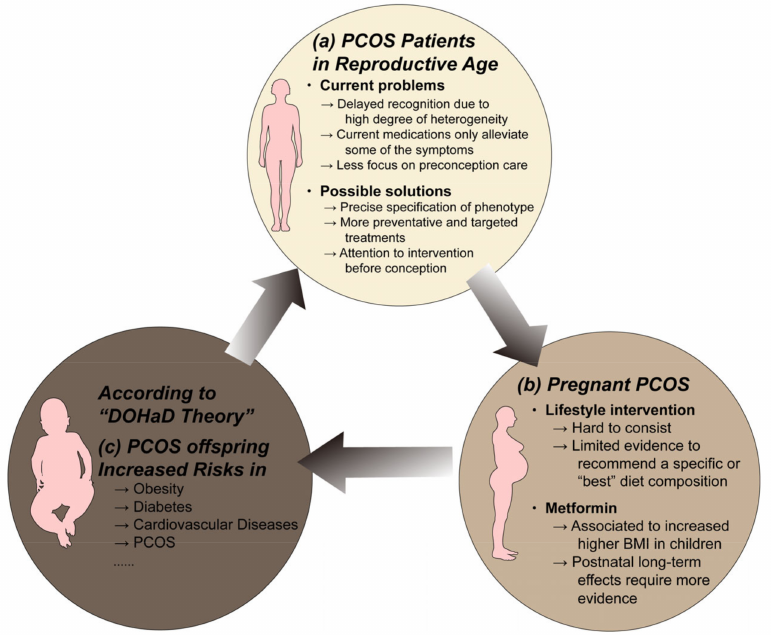
Figure 2. The vicious circle of intergenerational transmission of PCOS. (a) Many challenges remain in the diagnosis and treatment of PCOS in reproductive age. The concurrent metabolic disturbances in PCOS will bring risks to both mother's and offspring's health. (b) Lifestyle intervention and metformin are the first-line treatment for PCOS and they are safe for use during conception. However, their efficiency in benefiting PCOS offspring requires more evidence to demonstrate. (c) The adverse uterine environment caused by maternal PCOS, according to the DOHaD theory, may increase the susceptibility to non-communicable diseases of their offspring. The offspring of PCOS are vulnerable to serval metabolic diseases in their early adult life, which will also affect their children's health. How to break this vicious cycle remains a huge challenge for the future. Abbreviations: BMI, body mass index; DOHaD, developmental origins of health and disease; PCOS, polycystic ovary